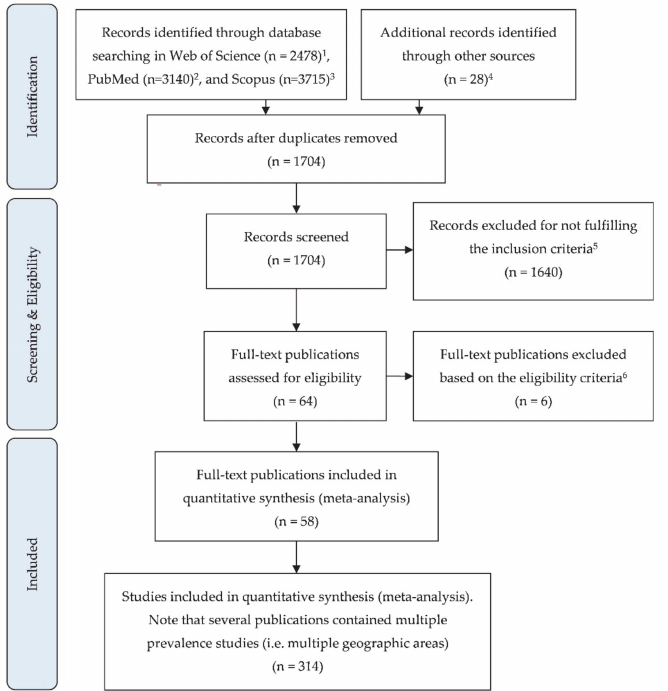
Figure A1. 1 Keywords in Web of Science. maedi: 1641; maedi prevalence: 196; maedi-visna: